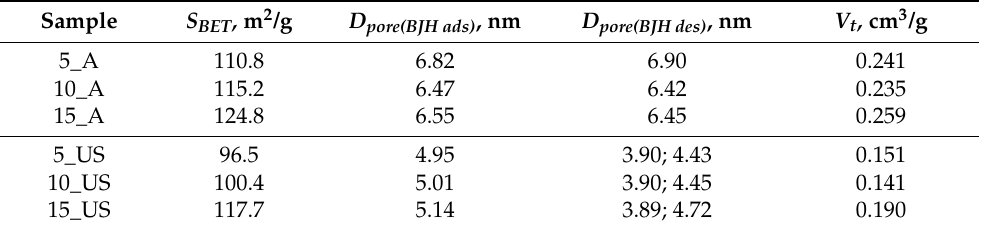
Table 3. Textural features derived from N 2 -sorption isotherms of the synthesized porous titania.